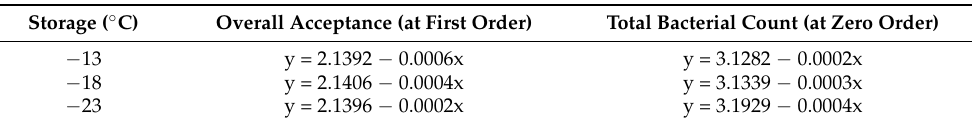
Table 11. Linear regression equation for overall acceptance and total bacterial count of braised mackerel with radish at selected